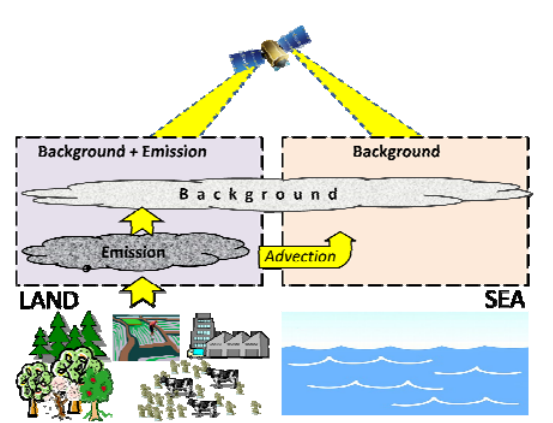
Figure 2 Overview diagram of advection of CH 4 emitted over land into the